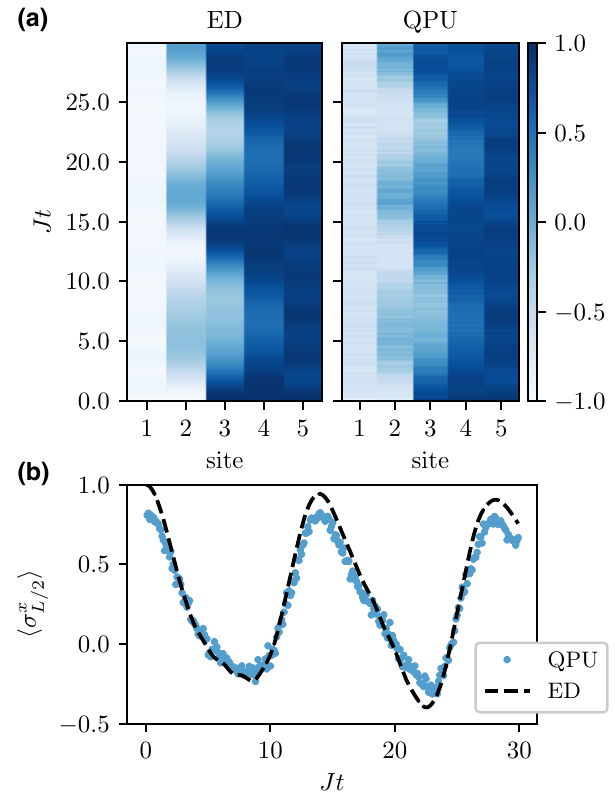
FIG. 6. We show the benchmark result for L = 5. Quenched dynamics from a product state with a single domain wall and Hamiltonian parameters g = 0.25, h = 0.2. (a) The (cid:4) σ x (cid:2) expec- tation values over the full system from ED simulation and measurements on the time-evolved states prepared on QPU. (b) (cid:2) expectation value on the central qubit measured on The (cid:4) σ x L / 2 the QPU and compared with ED. The data displayed is averaged over ten different circuit realizations (see Appendix